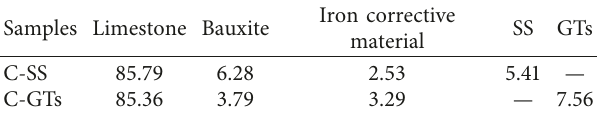
Table 2: Proportions of raw materials in two cement samples (%). Iron Samples Limestone Bauxite